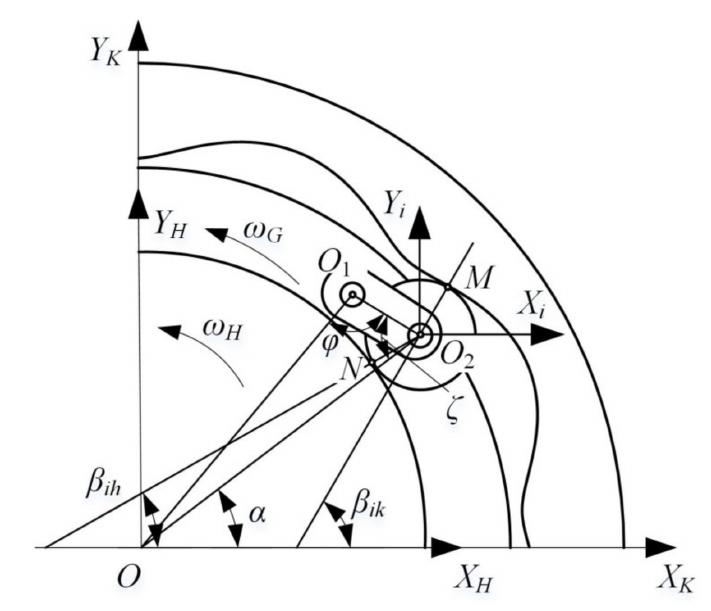
Figure 3. Relative displacement relation of